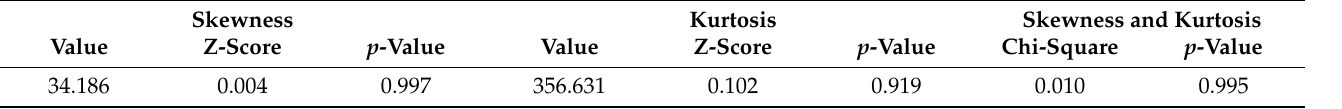
Table 7. Multivariate Normality Test Results.